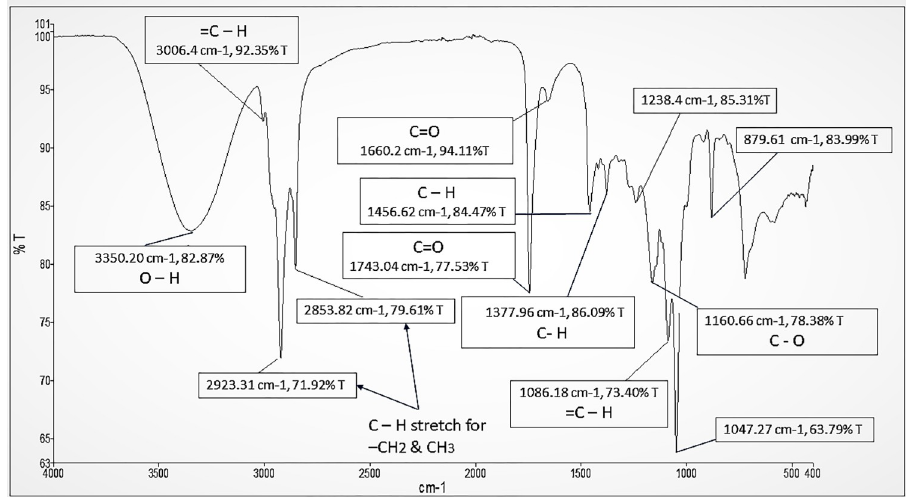
Fig 3. FT-IR spectrum of N . sativa seeds oil scanned at 4000–400 cm − 1. The spectrum illustrates the existence of a variety of peaks at specific wavenumbers that correspond to crucial functional groups that are present in N . sativa seeds oil extracted using absolute